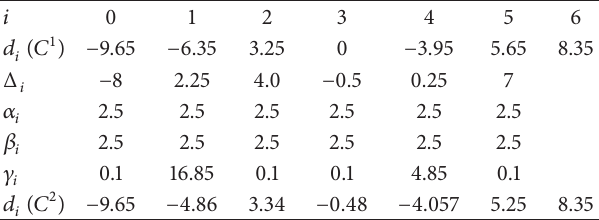
Table 6: Numerical